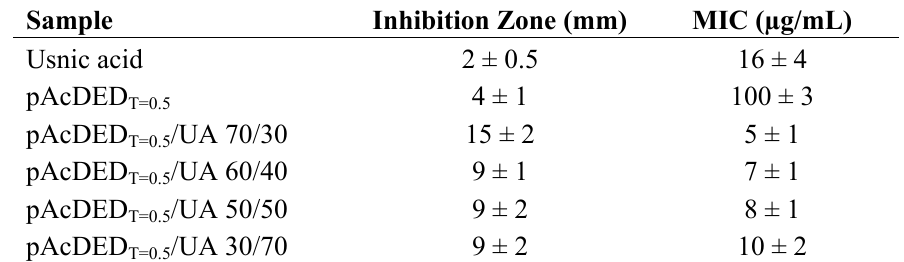
and pAcDED /UA T=0.5 T=0.5